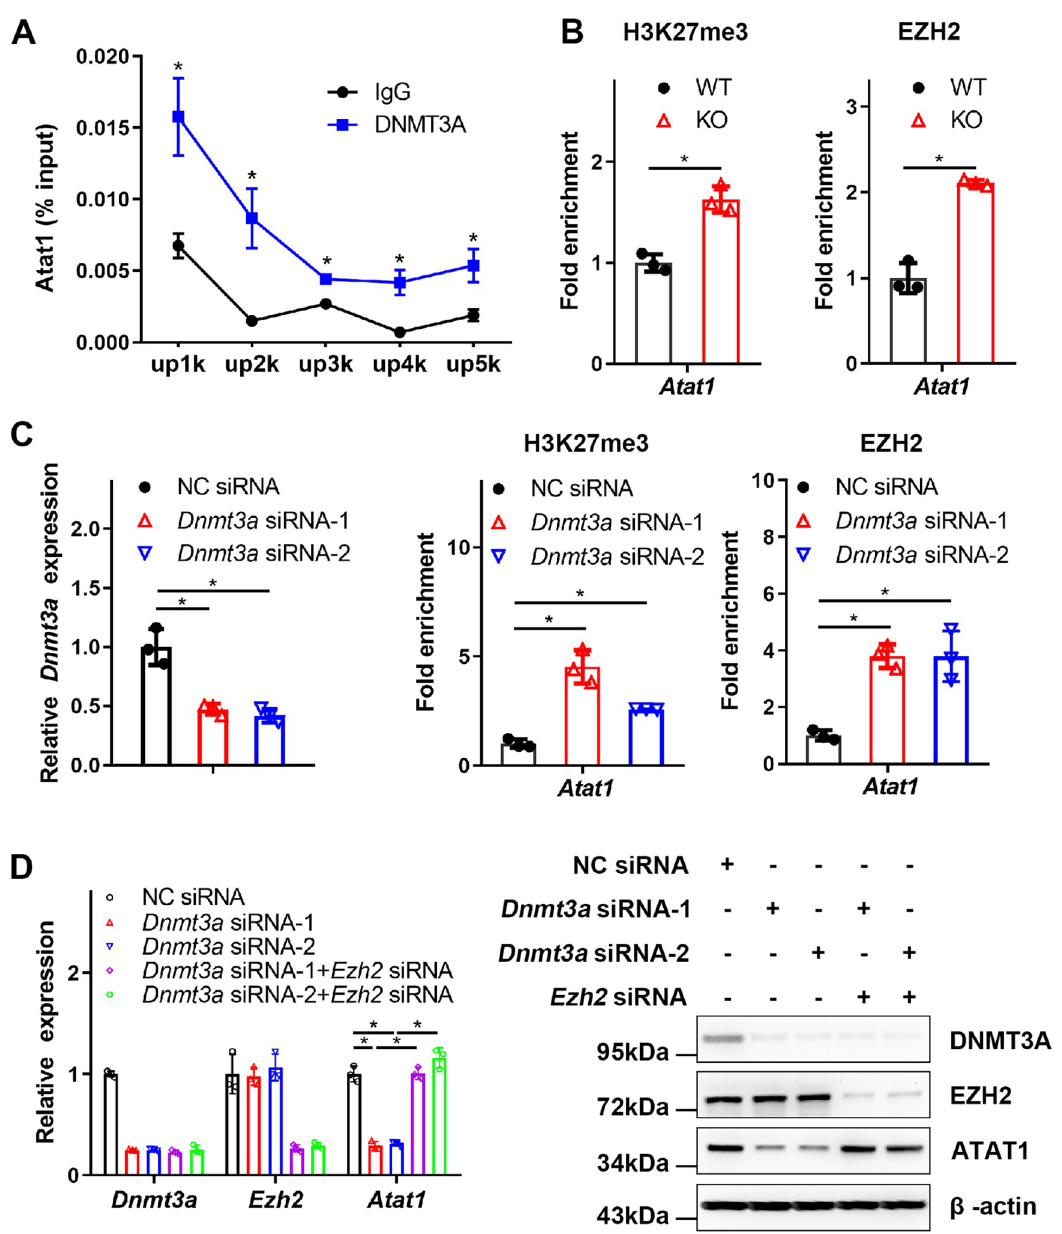
Fig 5. DNMT3A transcriptionally regulates the expression of ATAT1. (A) ChIP analysis of Dnmt3a at positions 5 kilobases (kb) (up5k), 4 kb (up4k), 3 kb (up3k), 2 kb (up2k), or 1 kb (up1k) upstream of the transcriptional start site of Atat1 in BMDMs. (B) ChIP analysis of H3K27me3 or EZH2 at the Atat1 promoter in the WT or KO BMDMs. (C) ChIP analysis of H3K27me3 or EZH2 at the Atat1 promoter in the DNMT3A knockdown BMDMs. (D) The expression of DNMT3A, EZH2, and ATAT1 was measured by qRT-PCR and western blot in the BMDMs transfected with NC, Dnmt3a , or Dnmt3a and Ezh2 siRNAs. All data in the figure are shown as the mean ± SD. P < 0.05 ( � ). Underlying data can be found in S1 Data. BMDM, bone marrow-derived macrophage; ChIP, chromatin immunoprecipitation; KO, knockout; NC, negative control; qRT-PCR, quantitative reverse transcription PCR; WT, wild